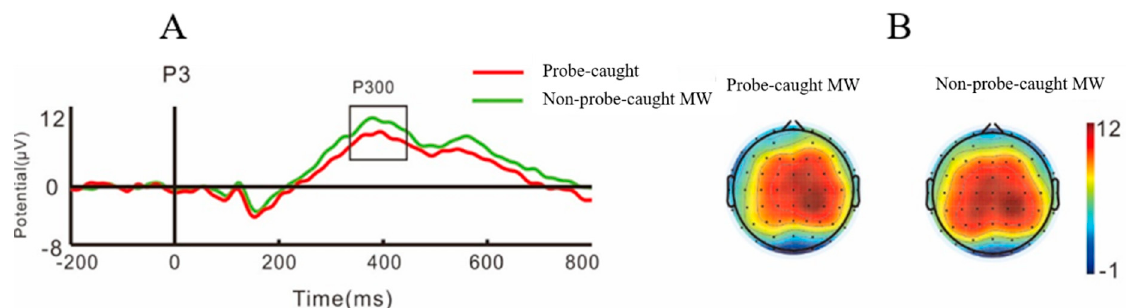
Figure 3. The mean amplitudes of P300 ( A ) and topography plots ( B ) during probe-caught MW and non-probe-caught MW.